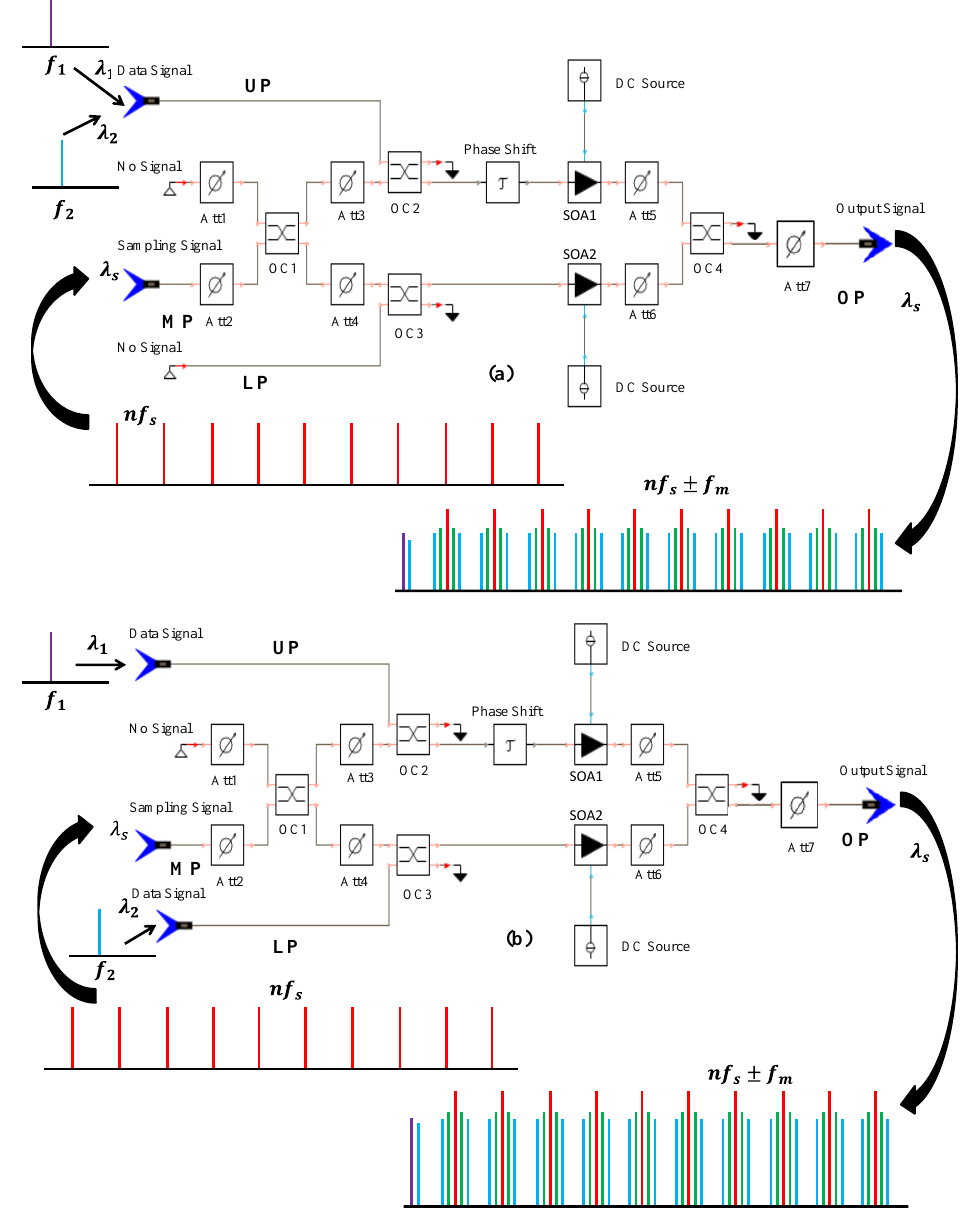
Figure 1. SOA-MZI in the co-direction configuration. Att: Attenuator, OC: Optical Coupler, MP: Middle Port, OP: Output Port, UP: Upper Port, and LP: Lower Port. ( a ) Standard modulation mode, ( b ) Differential modulation mode.